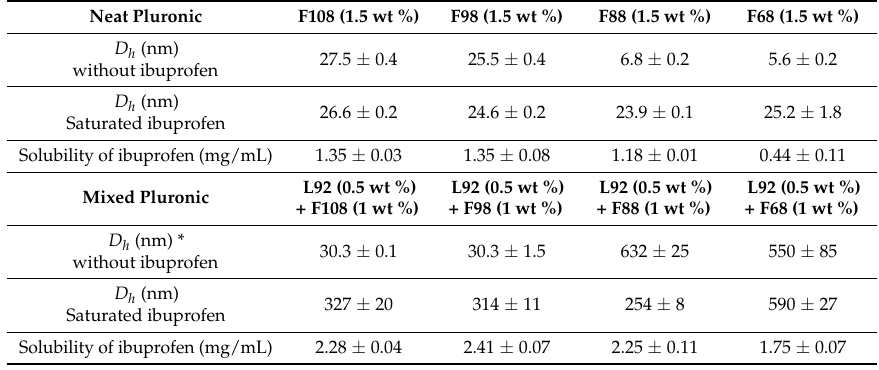
Table 2. Hydrodynamic Diameter of aggregates ( D h , nm) and solubility of ibuprofen in neat